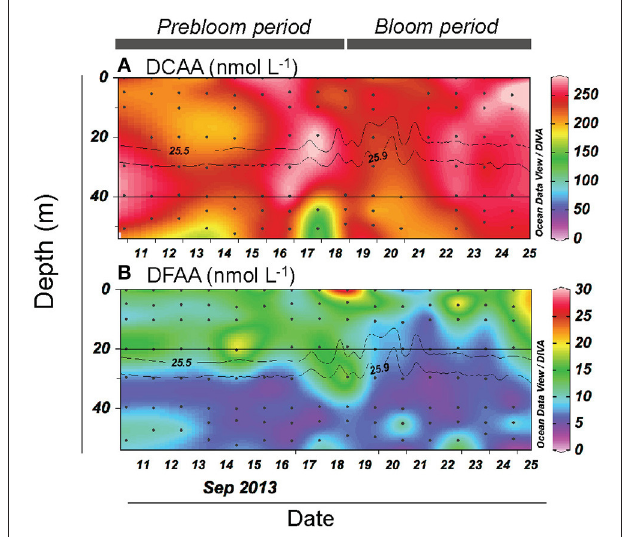
FIGURE 5 | Vertical and temporal variation in the concentration of (A) dissolved combined amino acid (DCAA) and (B) dissolved free amino acid (DFAA). Gray contour lines indicate potential density ( σ θ ). The contour graphs were created using Ocean Data View software (Schlitzer,